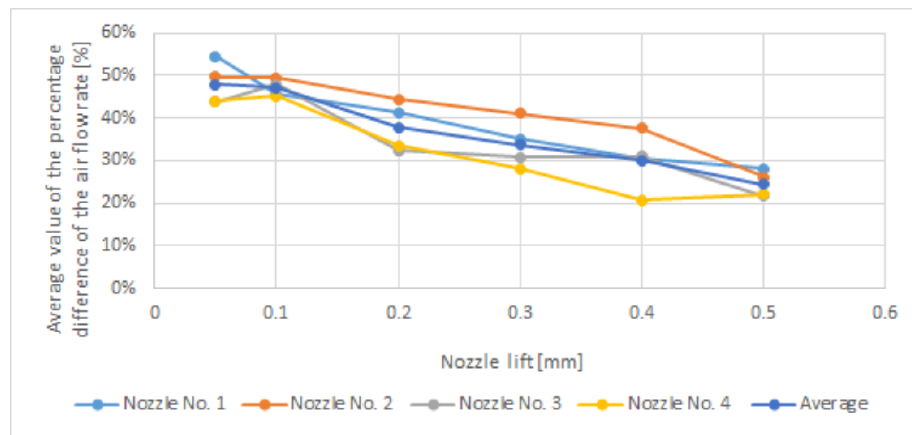
Figure 10. The mean value of the airflow rate for SD2.